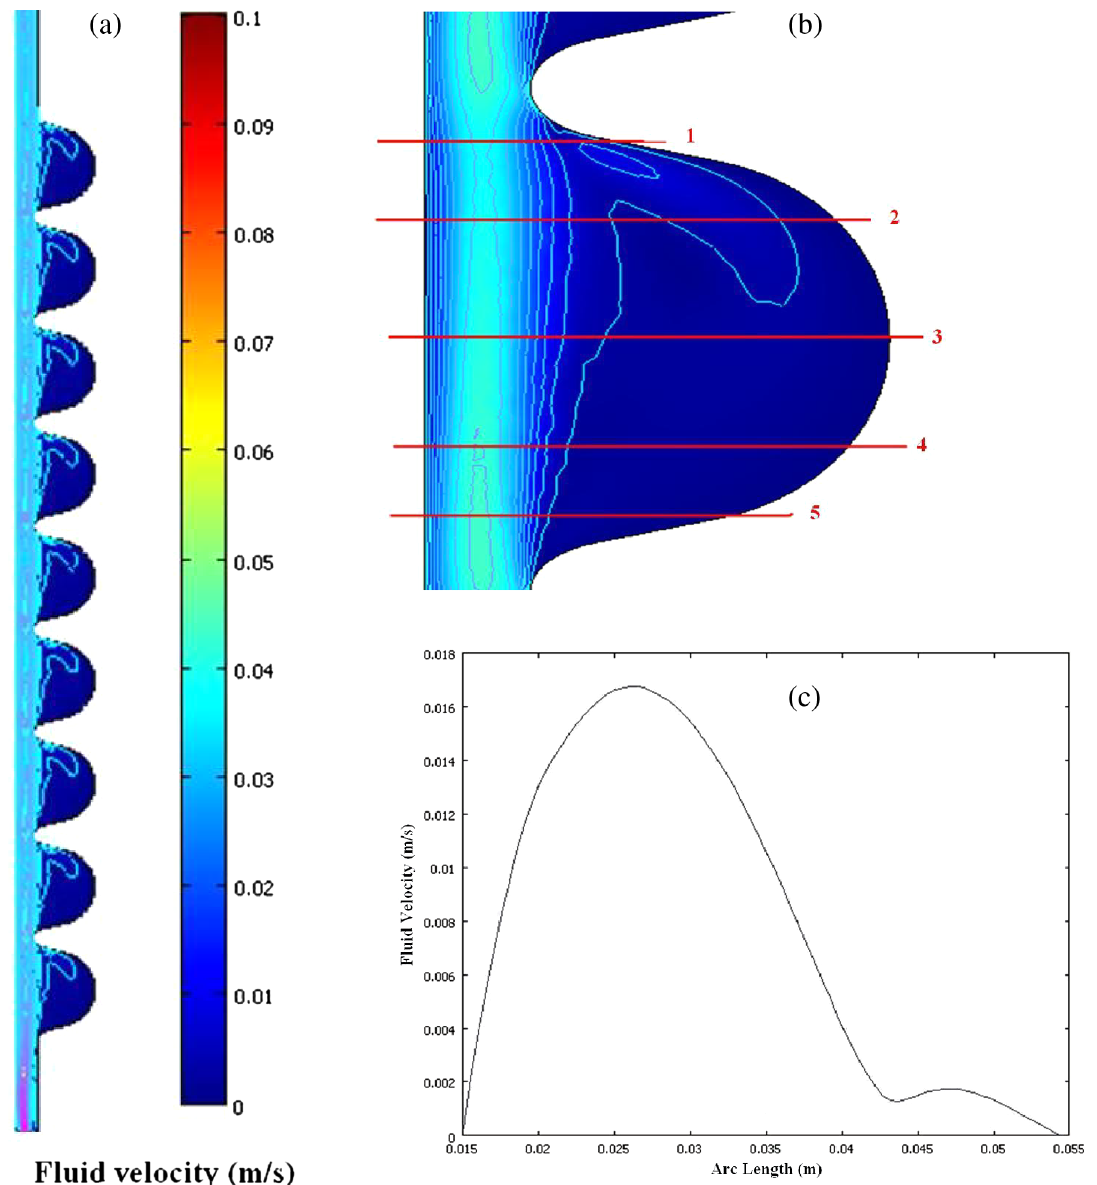
cells.FIG. 6. (a) Fluid modeling in the ILC cavity for vmax ¼ 0 : 2 m = s . (b) Zoom of the central cell. (c) For each line (1 to 5), the distribution profile between the cathode and the cavity wall is similar.